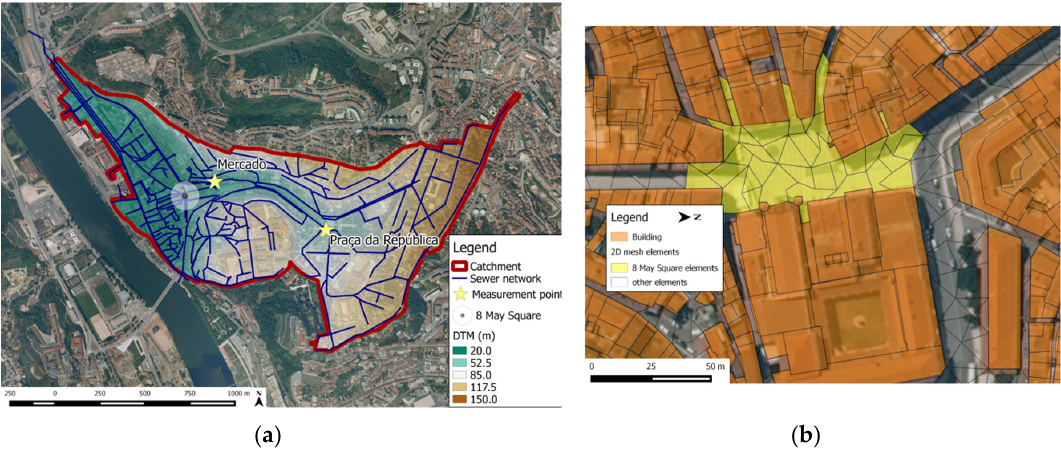
Figure 5. Zona Central catchment—Coimbra, Portugal: ( a ) sewer network, DTM and monitoring point locations; and ( b ) extents of Praça 8 de Maio.